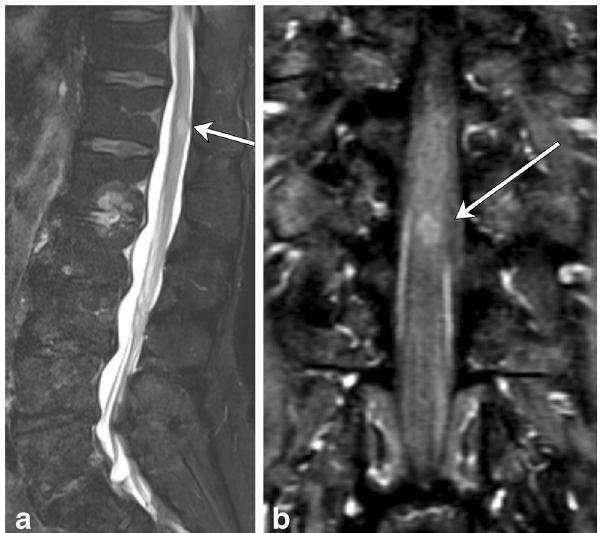
Fig. 16 Spinal Cord Metastasis. A 69-year-old male with a history of small cell lung cancer and new back pain. a There is a focus of intramedullary T2 hyperintensity (arrow), which enhances ( b , arrow) on the T1 post-contrast coronal